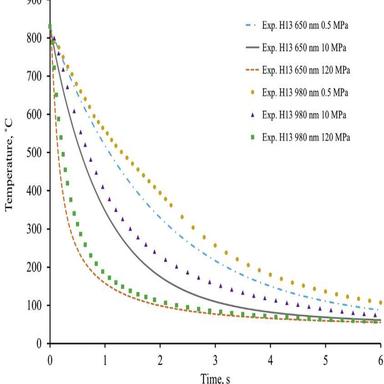
The percentage increase in the IHTC for the Ti-6Al-4V when the tool surface roughness decreased from 980 to 650 nm at different contact pressures.